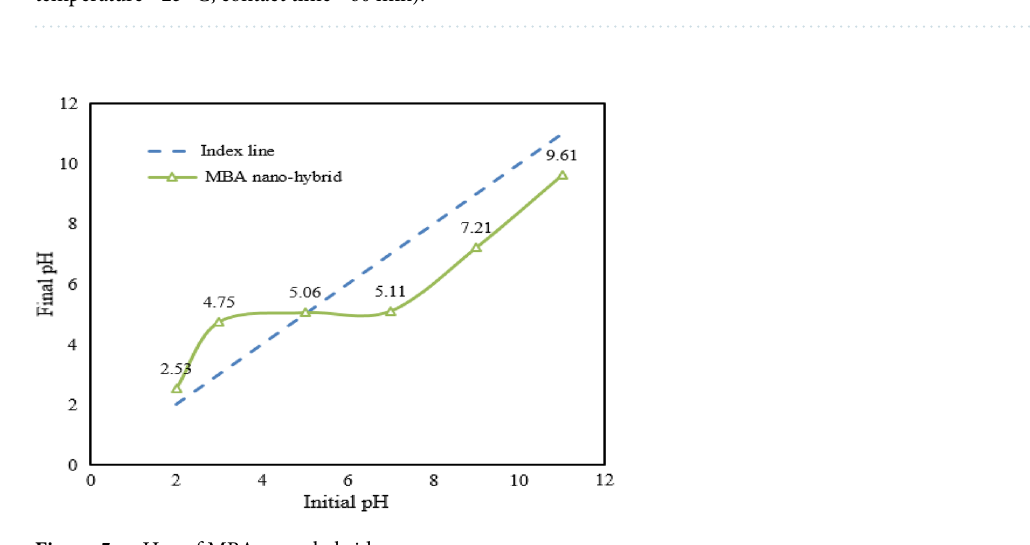
Figure 5. pH zpc of MBA